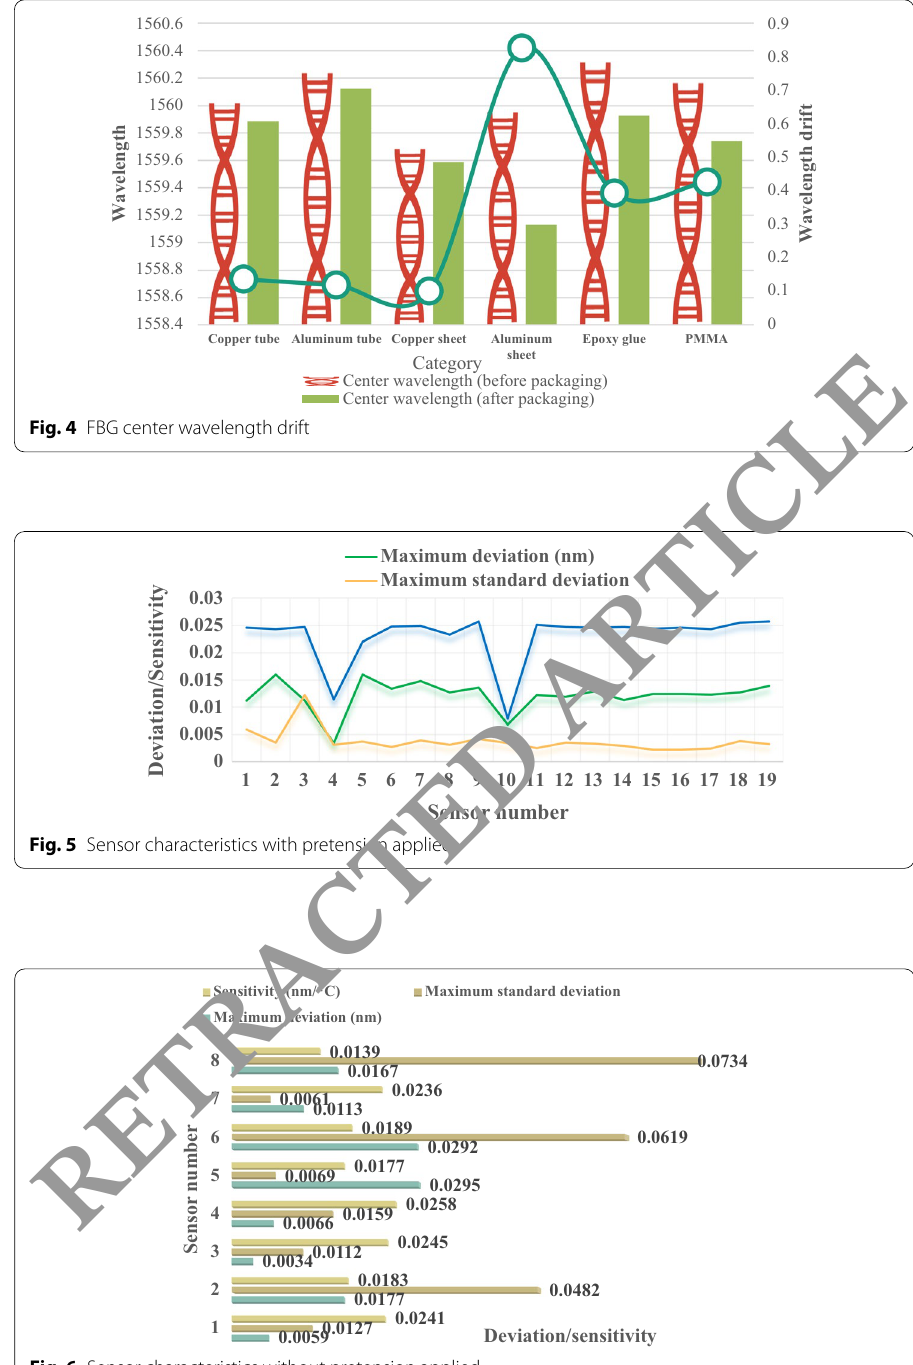
Fig. 6 Sensor characteristics without pretension